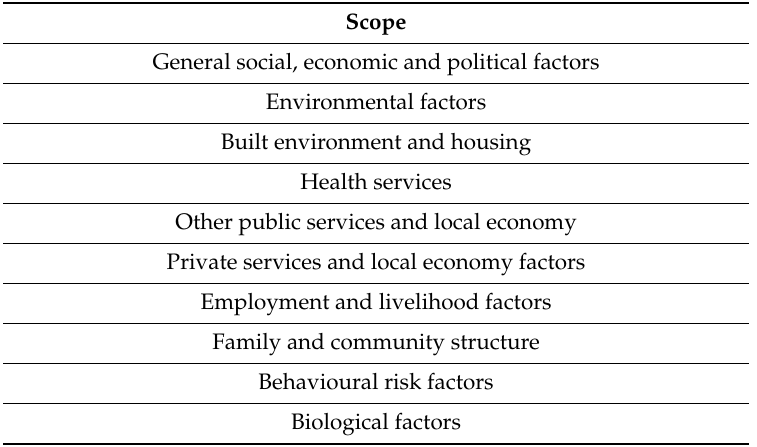
Table 2. Determinants of health as scope for EIA / SEA. Adapted from Nowacki, 2018